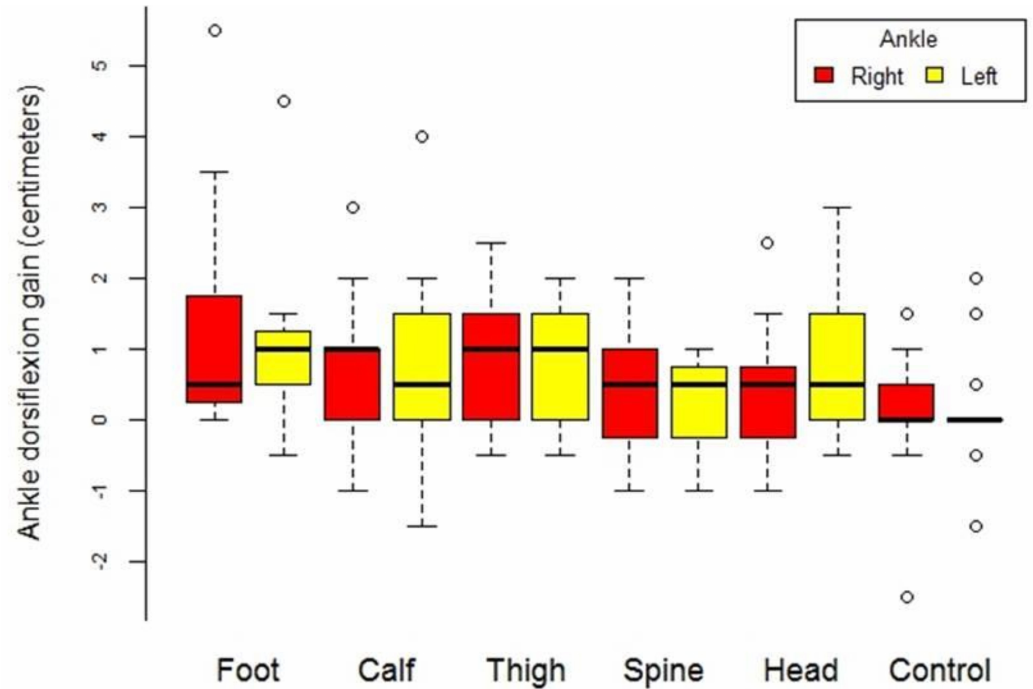
Figure 3. Box diagram of the gain of increase in ankle flexion-extension of the ankle by location of treatment location and by extremity (right and left).